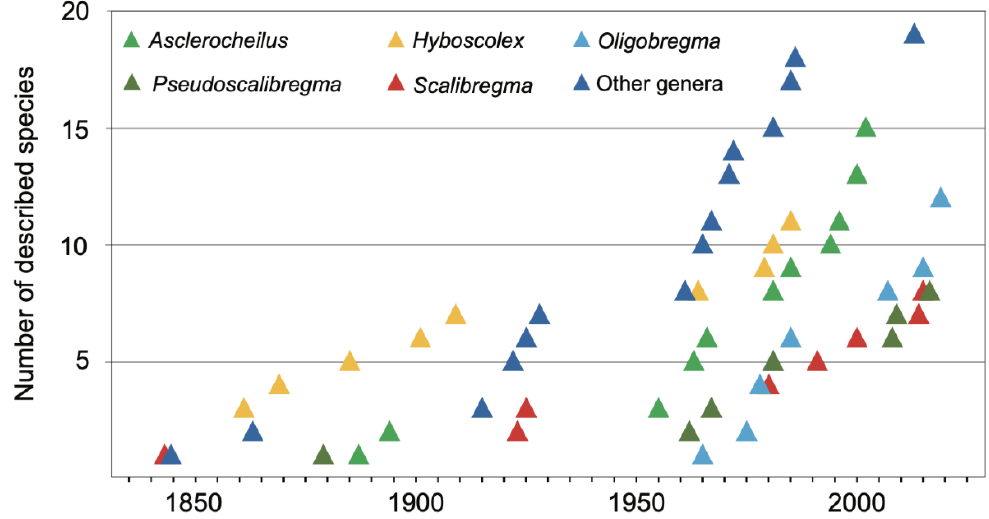
Figure 8. Number of described species (accumulated) of the main scalibregmatid genera from 1820 to 2020. Genera with less than five described species have been grouped under “Other genera”.